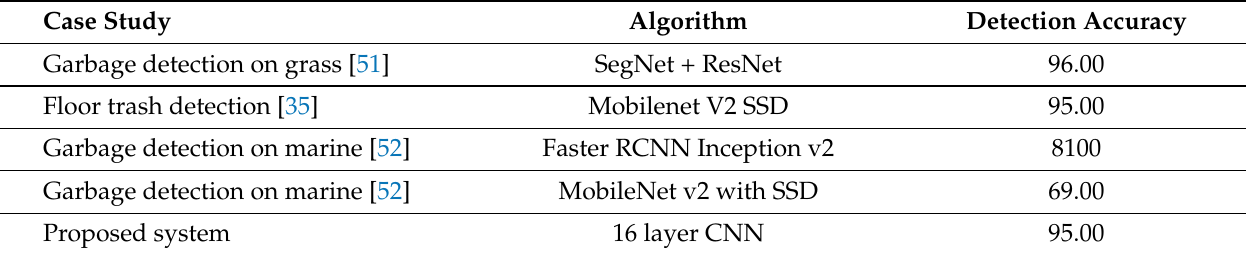
Table 8. Comparison with other garbage detection